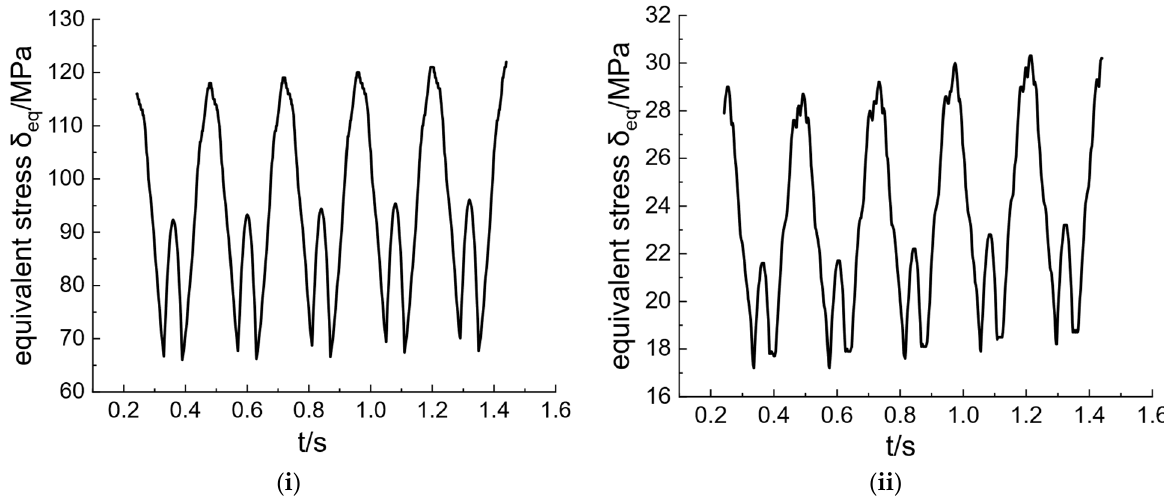
Figure 9. Stress curves of turbine working conditions. ( i ) 0.6 Q, ( ii ) 1.0 Q.